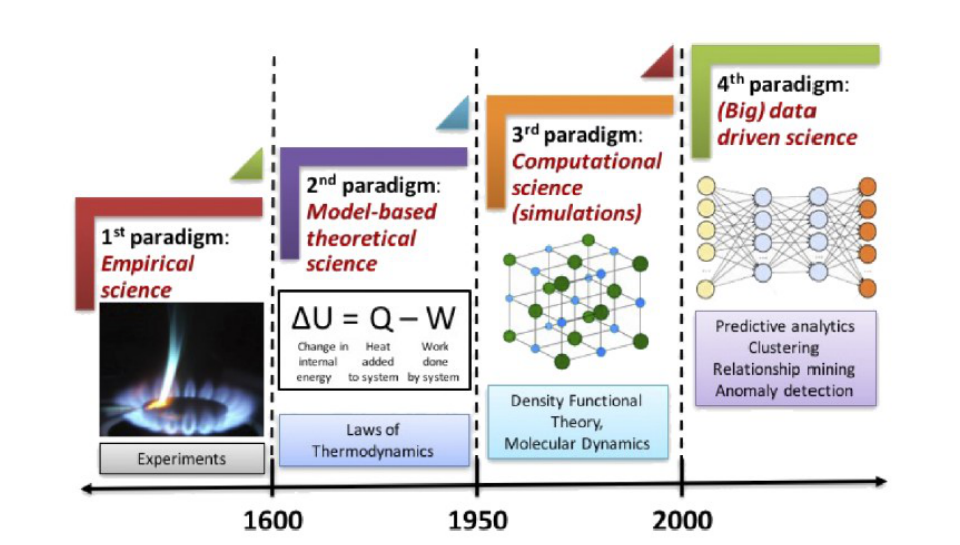
Figure 5. The chronology of four scientific paradigms in context of materials science starting from empirical, theoretical, computational to data-driven approach